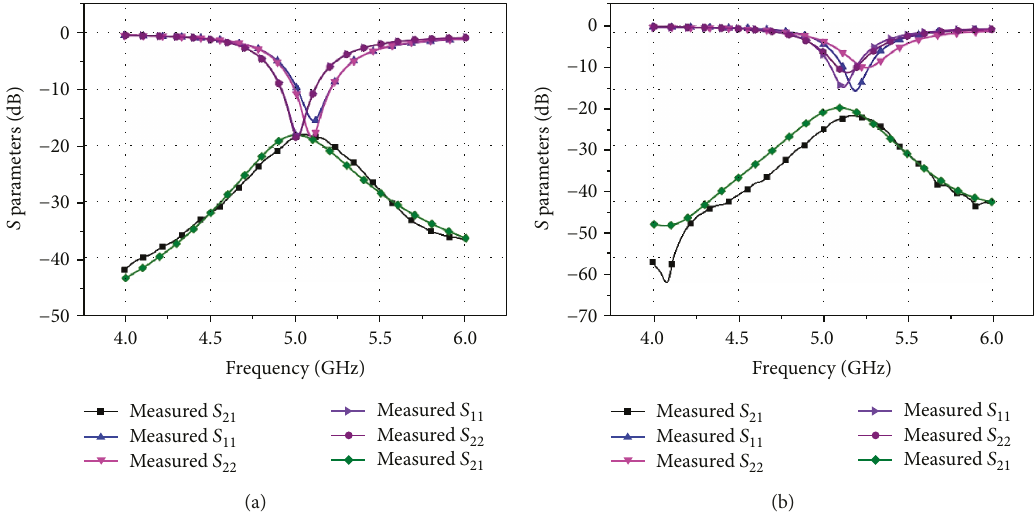
Figure 7: (a) Simulated and measured S parameters of prototype A. (b) Simulated and measured S parameters of prototype